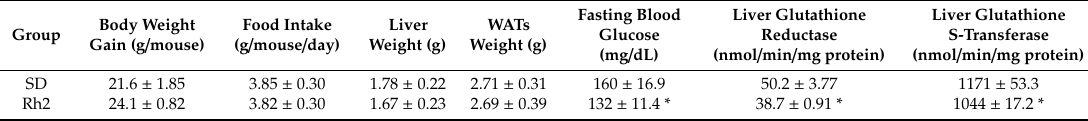
Table 1. Bodyweight gain, food intake, weight of liver, weight of white adipose tissues (WATs), fasting blood glucose, and hepatic antioxidants in obese mice.